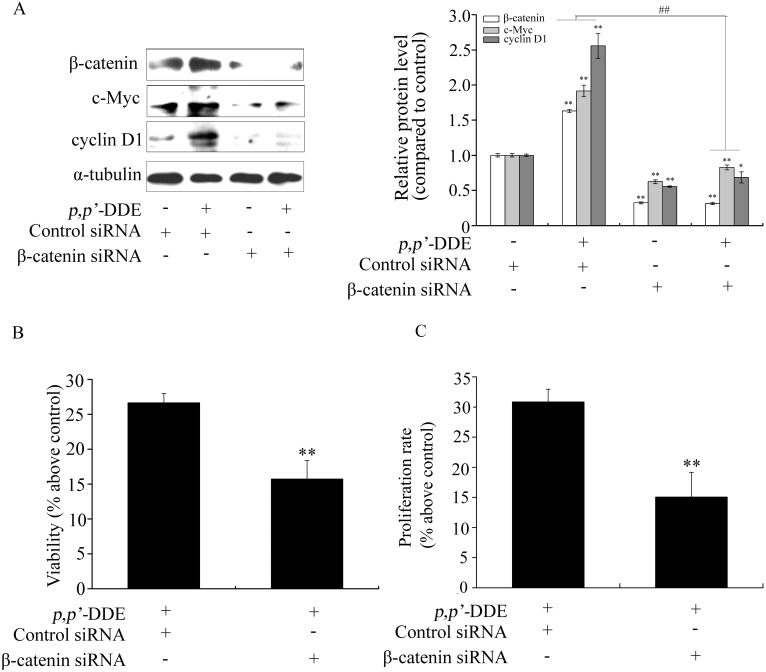
Inhibition of Wnt/β-catenin signaling blocks p,p′-DDE-induced DLD1 cell proliferation.After DLD1 cells were transfected with control siRNA or β-catenin siRNA, followed by treating with p,p′-DDE (10−9 M) for 96 h, (A) western blotting was performed to analyze β-catenin, c-Myc and cyclin D1. α-tubulin was used as a control; Images are representative of three independent experiments that showed similar results. Grayscale scan analysis of western blot bands were shown in right panel of graph. *p<0.05 and **p<0.01 compared to the cells only transfected with control siRNA. ##
p<0.01 compared to the cells transfected with β-catenin siRNA along with p,p′-DDE treatment. (B) Cell viability and (C) proliferation rate were analyzed by MTT and cell number assay. Values are percent as the mean ± SD of three independent experiments. **p<0.01 compared to control.